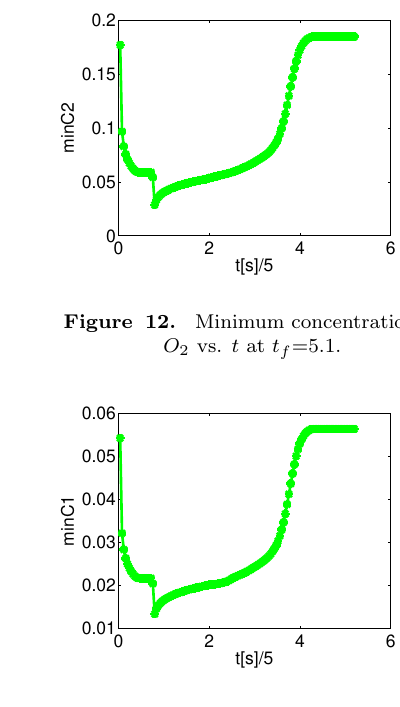
Figure 14. Minimum concentration of propane vs. t at t f